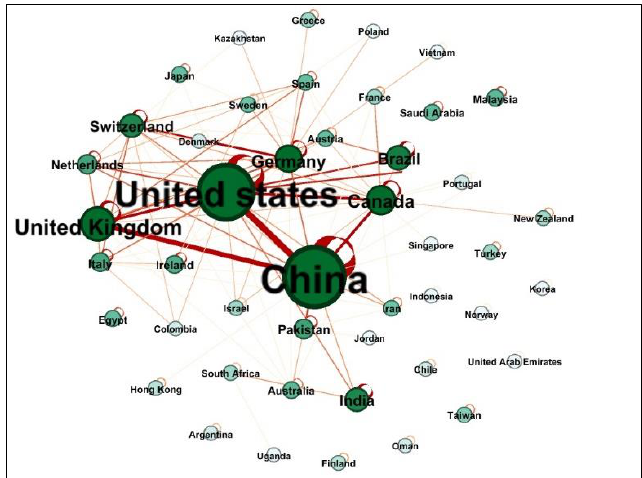
Figure 9. Countries involved in co-authorship networks.